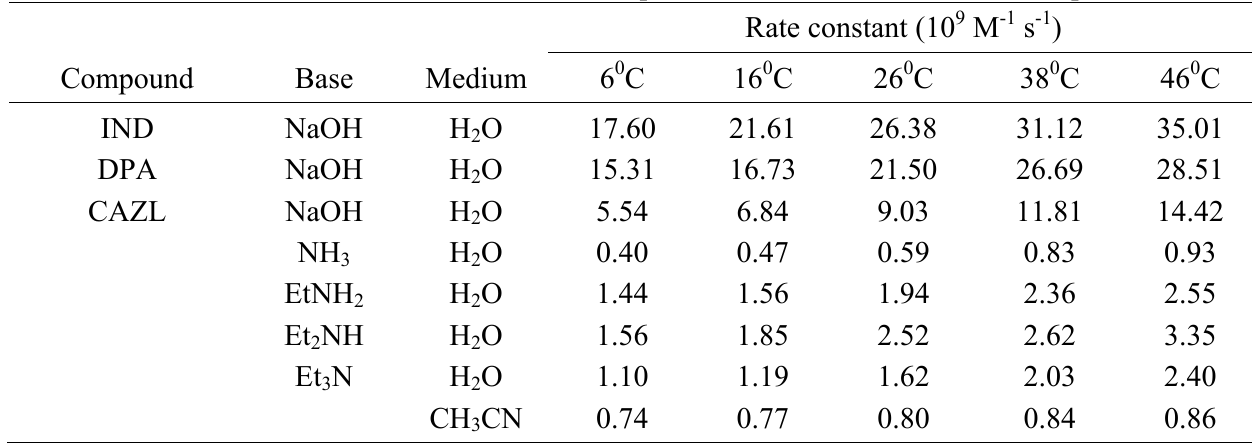
Table 4. Rate constants for different excited state deprotonation reactions at various temperatures.